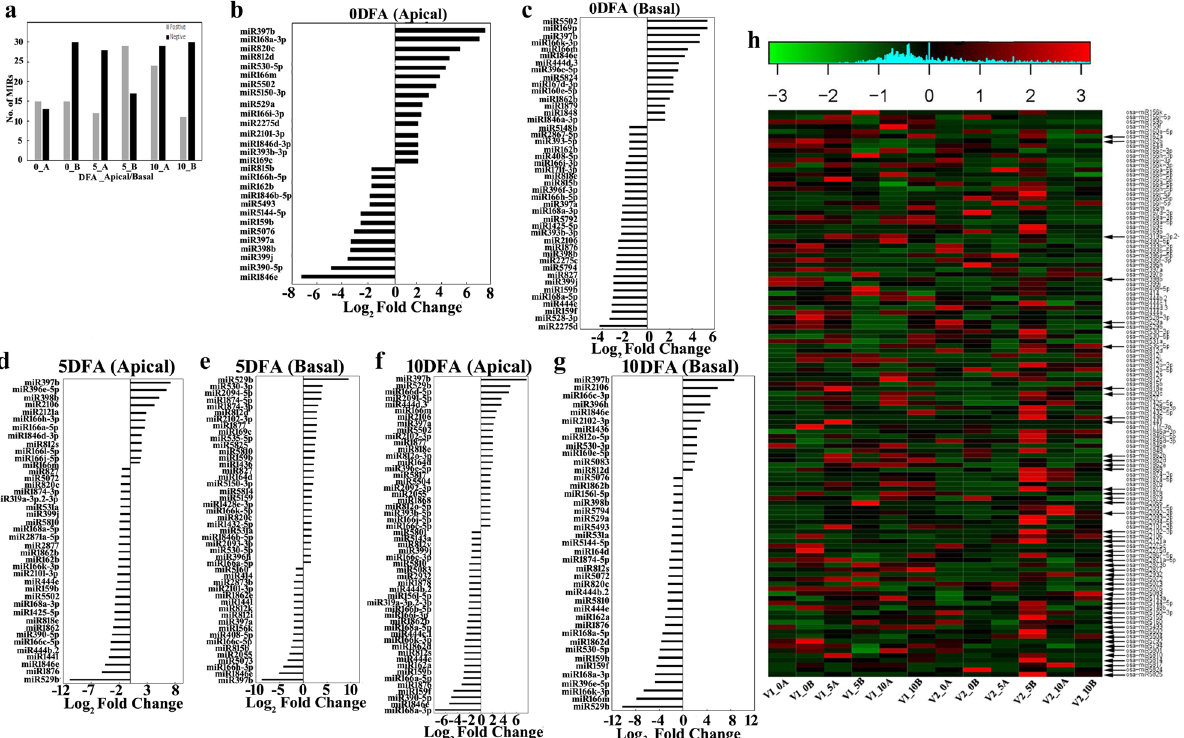
Figure 5. Differential gene expression (DGE) of miRNAs of apical and basal spikelets in V2 (SR-157) over V1 (SR-159) during post-anthesis (0, 5 and 10 days) using DESeq8 tool ( a ). DGE of miRNAs of V2 (SR-157) over V1 (SR-159) based on read length showing UP-regulation or DOWN-regulation after anthesis on 0 day in apical spikelets ( b ), 0 day in basal spikelets ( c ), 5 days in apical spikelets ( d ), 5 days in basal spikelets ( e ), 10 days in apical spikelets ( f ), 10 days in basal spikelets ( g ). Heat map showing DGE analysis of selected miRNAs in apical and basal spikelets of V1 (SR-159) and V2 (SR-157) on days 0, 5 and 10 after anthesis. Here, Log 2 fold change of 1 was used as cut off, miRNAs > 1 were considered “UP- (red colour code)” regulated, miRNAs < -1 considered “DOWN- (green colour code)” regulated and those between 1 and − 1 were considered as “NEUTRAL (black colour code)” ( h